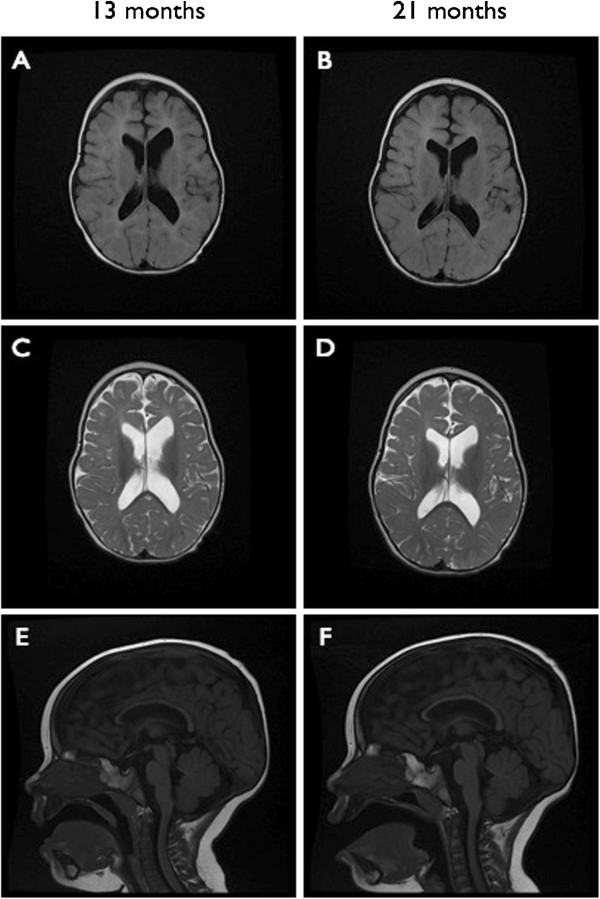
MRI images taken at 13 and 21 months of age. (A, B) Axial FLAIR images show only minimal interval progression in myelination over a 9 month span, with diffuse thinning of periventricular white matter evident at 13 months. (C, D) Axial T2-weighted images show markedly delayed myelination, with mild ventricular dilatation and slight enlargement of the frontal extra-axial spaces. (E, F) Sagittal T2-weighted images show a diffusely thin corpus callosum. MR spectroscopy demonstrated normal peaks of NAA, creatine and choline, and absence of a lactate peak.